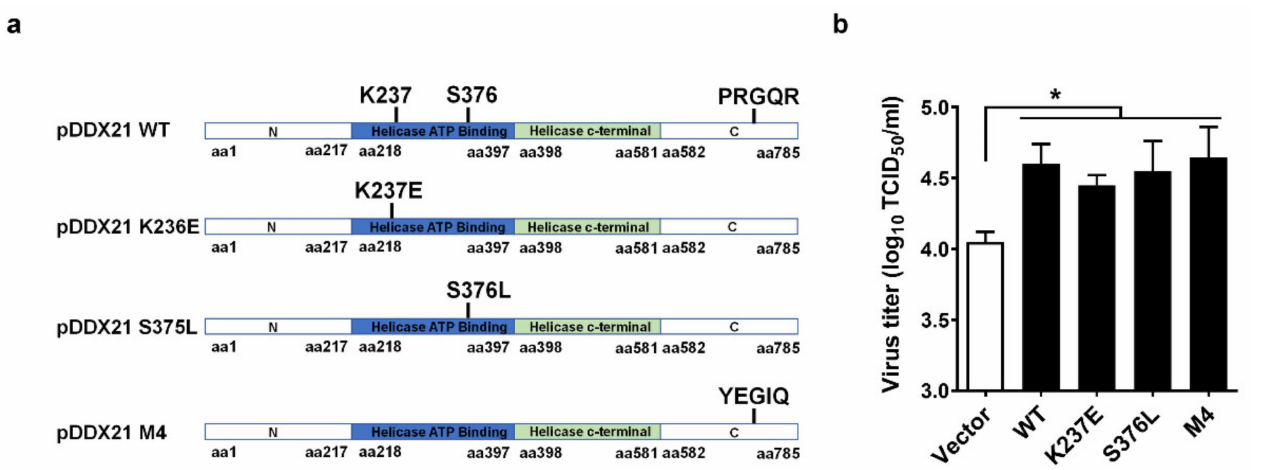
Figure 2. pDDX21 promotes PRRSV replication independently of its ATPase, RNA helicase, and foldase activities. ( a ) Schematic representation of wildtype (WT) pDDX21 and its mutants (K237E, S376L, M4). ( b ) iPAM cells were transfected with pCAGGS-Flag-pDDX21-WT (3 µ g), pCAGGS-Flag- pDDX21-K237E (3 µ g), pCAGGS-Flag-pDDX21-S376L (3 µ g), pCAGGS-Flag-pDDX21-M4 (3 µ g), or empty vector (3 µ g) for 30 h, and then infected with PRRSV (MOI = 0.1). At 24 hpi, the cells were collected and the viral titers were determined by TCID 50 assay. Data are presented as the means ± SD of three independent experiments (* p <